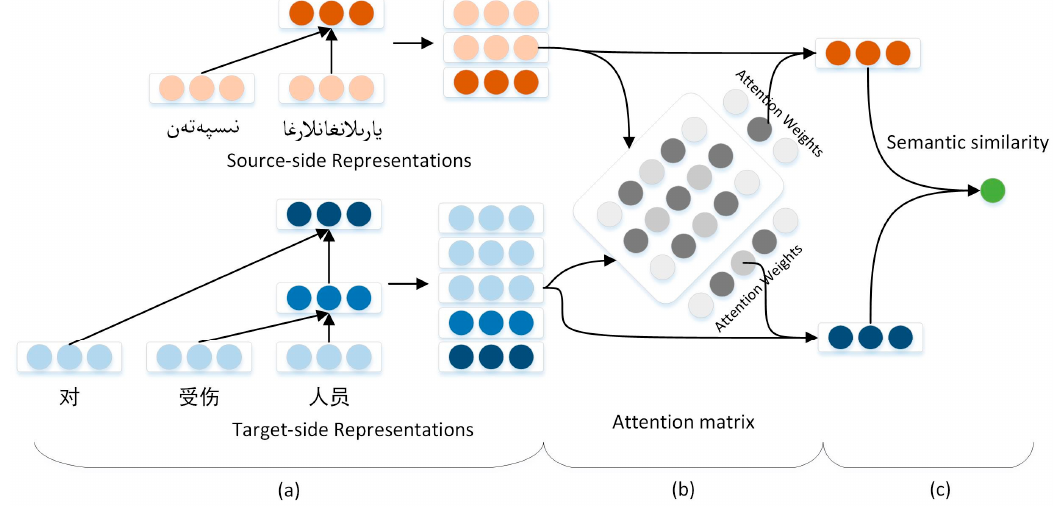
Figure 2. Overall architecture for the model: ( a ) Recursive autoencoders ( b ) bidimensional attention network; and ( c ) semantic similarity layer.